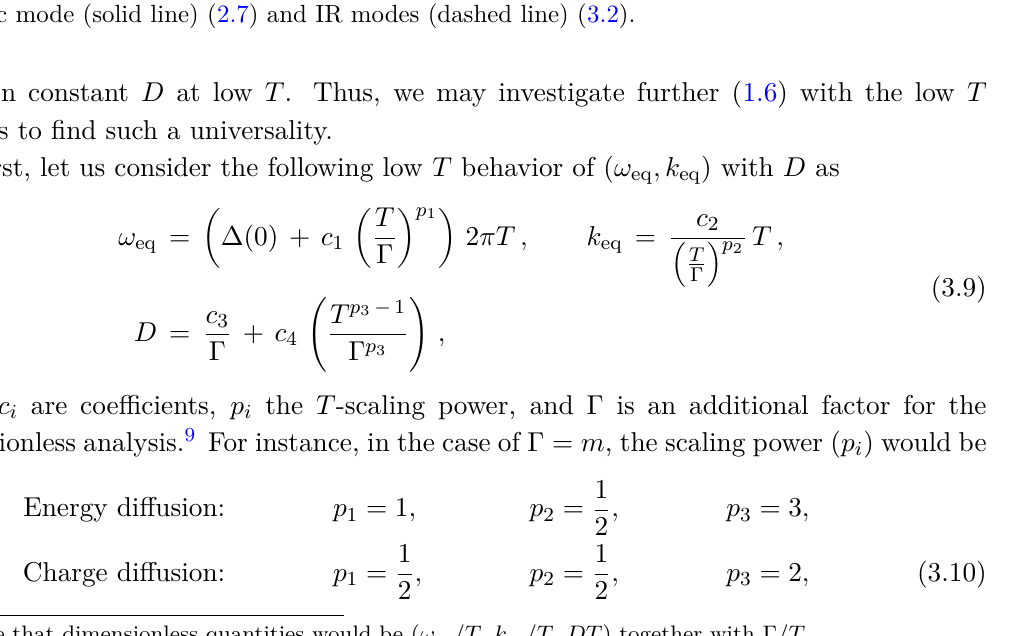
Figure 5 . Quasi-normal modes with different T . As the temperature T is lowered from figure 5(a) to figure 5(b), quasi-normal modes (dots) are getting better and better approximated with hydro- dynamic mode (solid line) (2.7) and IR modes (dashed line)